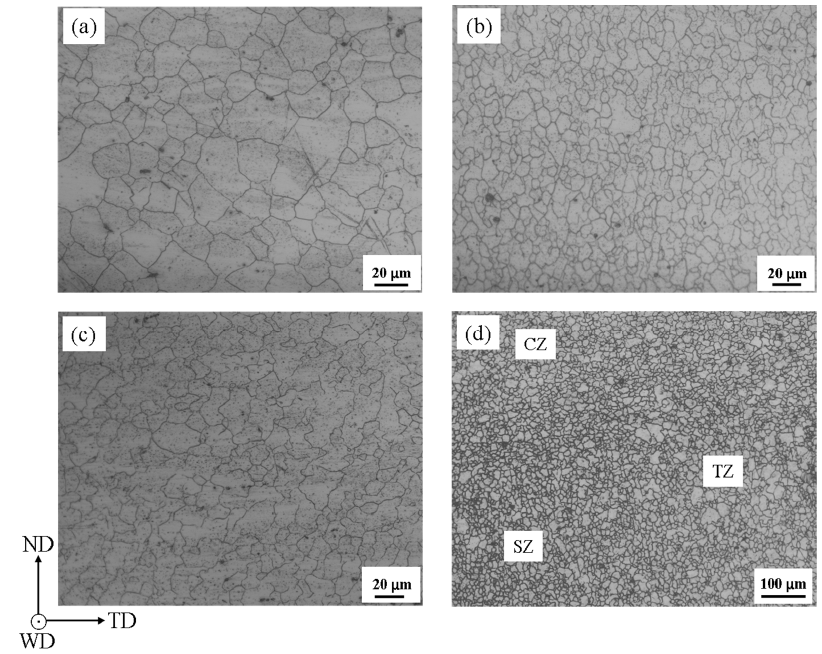
Figure 3. The metallographic photos in TMAZ ( a ), SZ ( b ), CZ ( c ) and the triple junction region ( d ) of undeformed sample. undeformed sample. Materials 2019 , 12 , x FOR PEER REVIEW